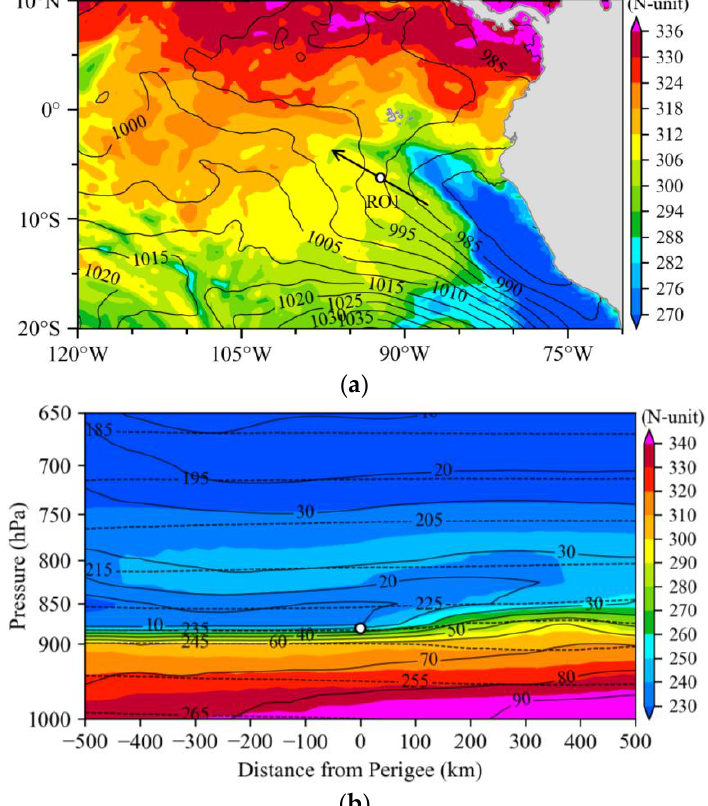
Figure 4. ( a ) Horizontal distribution of refractivity (shaded) and geopotential height (contours, unit: gpm,) at 900 hPa, and ( b ) vertical cross-section of total refractivity (shaded), wet refractivity (solid curve) and dry refractivity (dashed curve) along the tangent direction (black arrow) of RO1 at the perigee point (black open circle). The refractivity is calculated from ERA5 reanalysis at 0700 UTC,